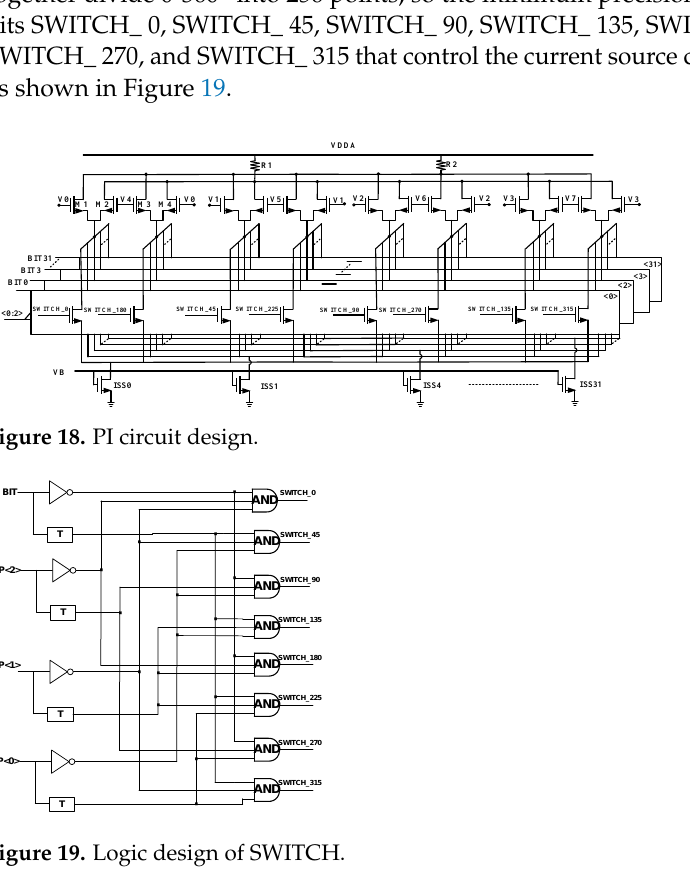
each differential pair is composed of 32 controllable current sources, and R1 and R2 are used as load resistors. The phase control terminal is P<0:2>, which are derived from the Weight Encoder in the CDA module proposed above. BIT0-BIT31 are the phase thermometer codes